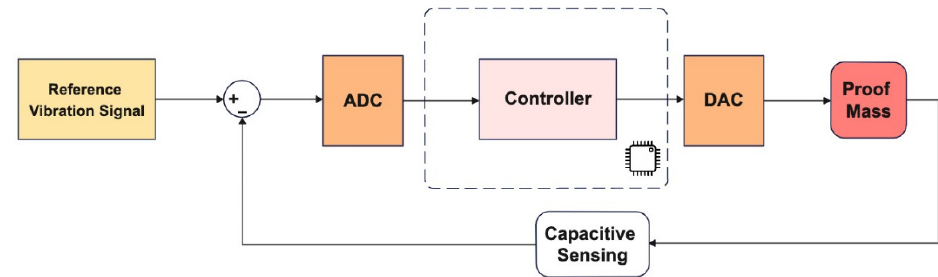
Figure 3. Gyro Drive Axis Controller Application.